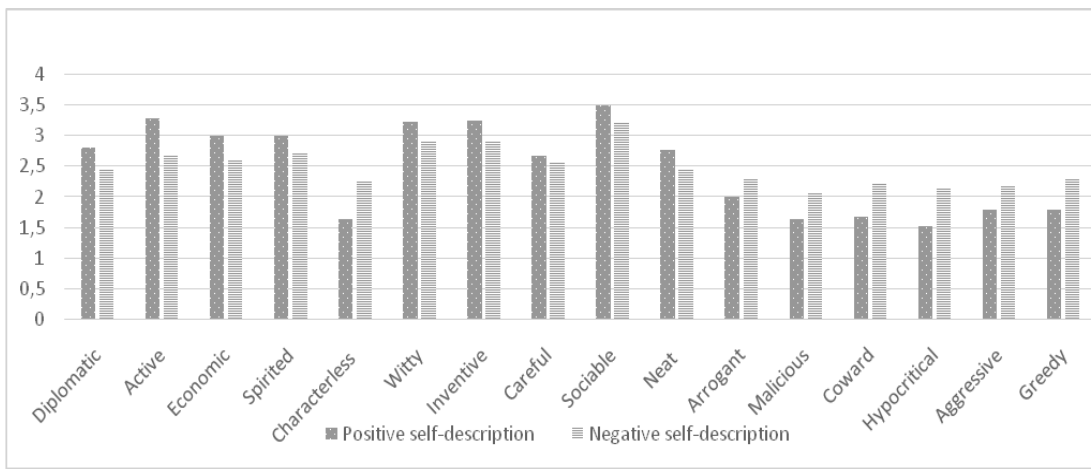
most positive and most negative self-description.